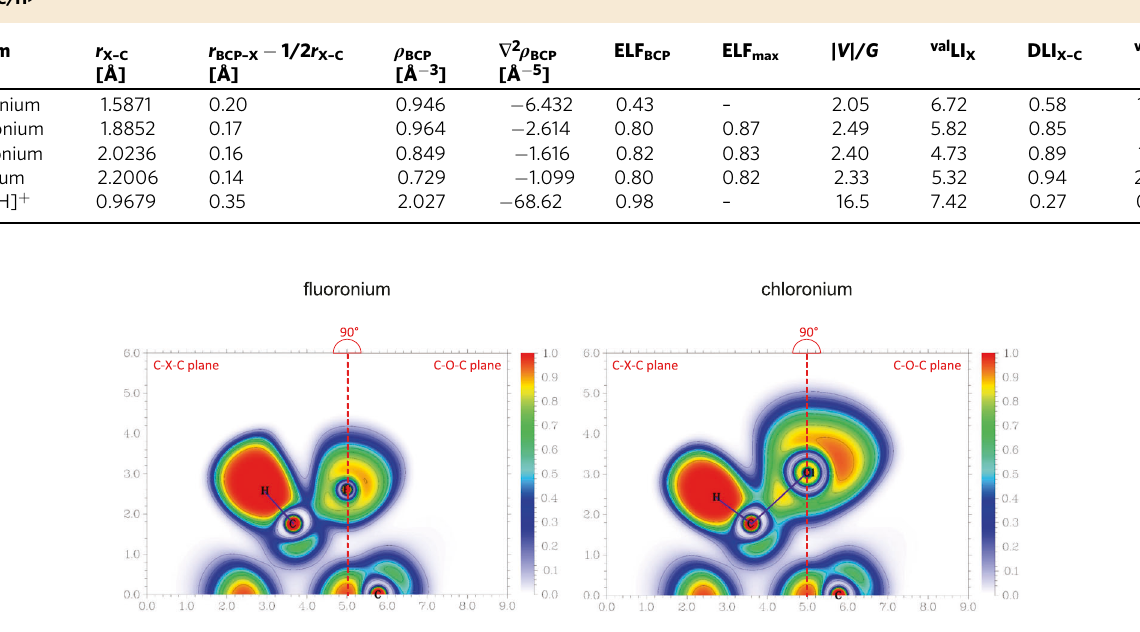
Table 2 Computed properties of the bonds to the halogen atom in different double-norbornyl type halonium ions: bond length ( r X – C ); deviation of the BCP from the mid-point of the bond ( r BCP – X − ½ r X – C ; for negative values, the BCP is closer to the halogen atom, for positive values, vice versa); electron density at the BCP ( ρ BCP ); Laplacian at the BCP ( ∇ 2 ρ BCP ); ELF at the BCP (ELF BCP ); value of the ELF maximum along the bond path (ELF max ); ratio of the absolute potential and the kinetic energy density at the BCP (| V |/ G ); localization index of the valence electrons at the halogen atom ( val LI X ); delocalization index of the bonds with the halogen atom (DLI X – C ); localization index of the valence electrons at the carbon or hydrogen atom bound to the halogen atom ( val LI C/H ).